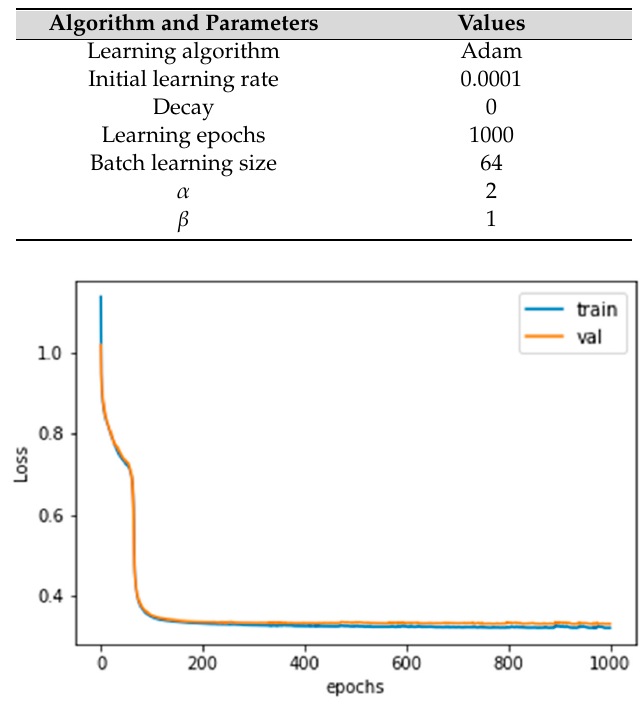
Table 1. The training algorithm and parameters.